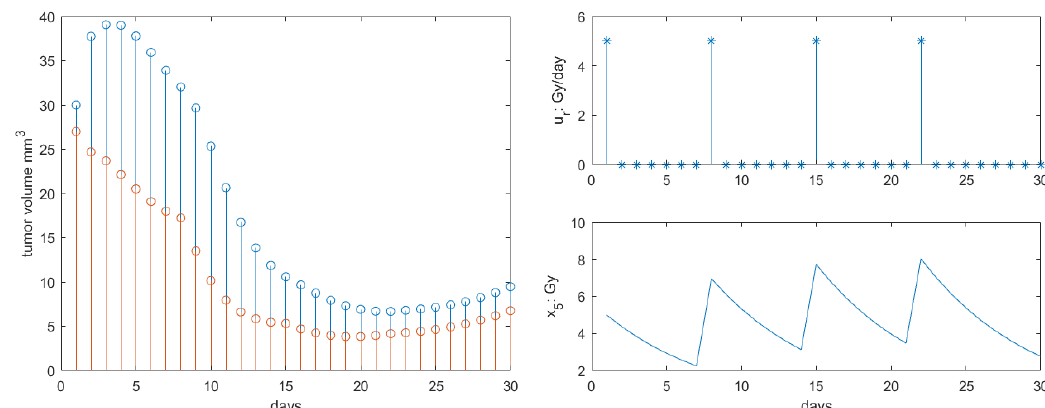
Figure 4. Results obtained for Protocol 1. Left : total tumor growth (blue stems) and necrotic tumor volume (red stems) response to therapy. Right : radiotherapy profile along with concentration profiles in body.